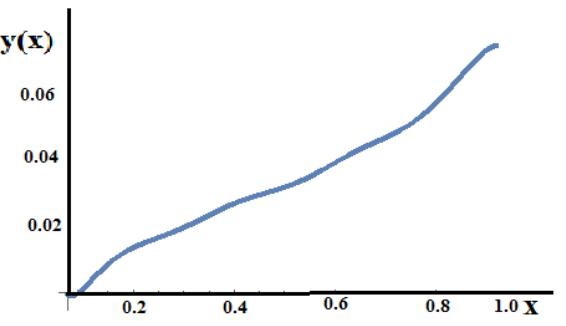
Figure 21. The distribution of the two side fractional stresses along the fractal bar. The maximum stresses are located around the poles. Further, proceeding to the final distribution of the displacement field is the mean value of the left and right distribution of the displacement fields of the fractal bar, as shown in Figure 22.